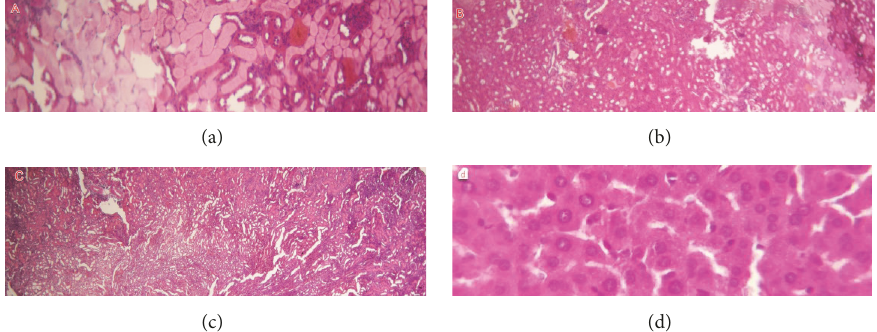
Figure 3: Histologic section of kidney tissue of control and treated mice (section of parenchyma stained with H&E, x 40). (a), (b), and (c) are histologic sections of kidney tissue of treated mice with 1.5 and 2 g/kg/day; (d) is a section of kidney tissue of control